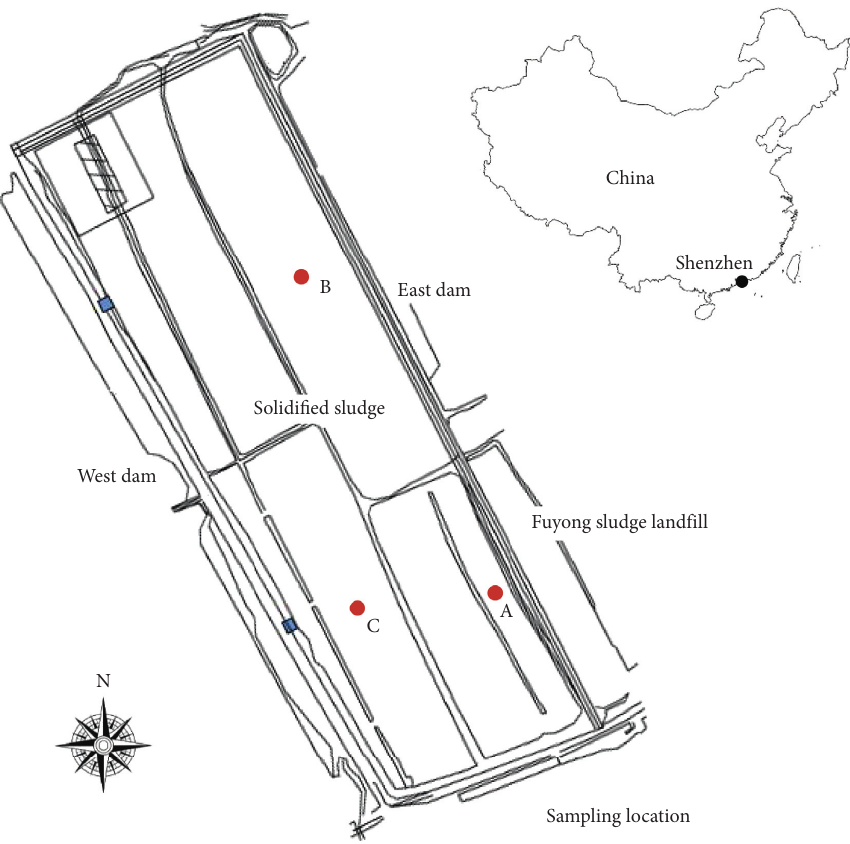
Figure 1: Plan view of Fuyong sludge landfill.